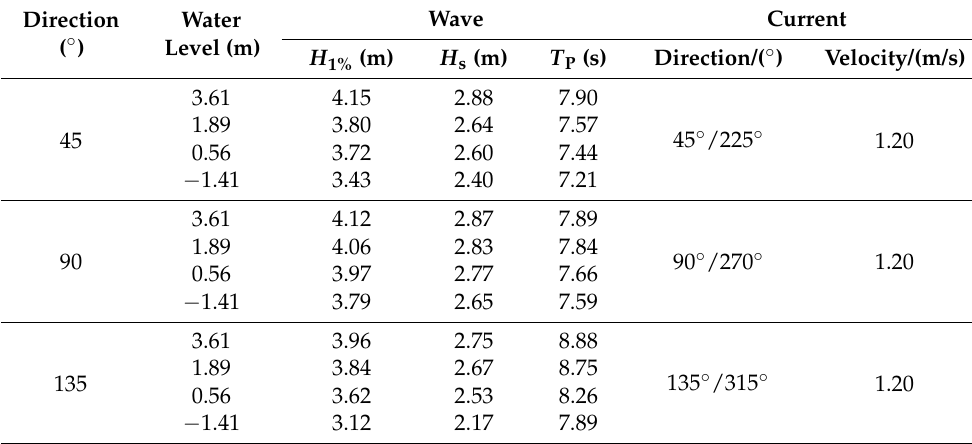
Table 1. Test conditions (note: the values in the table are prototype values).